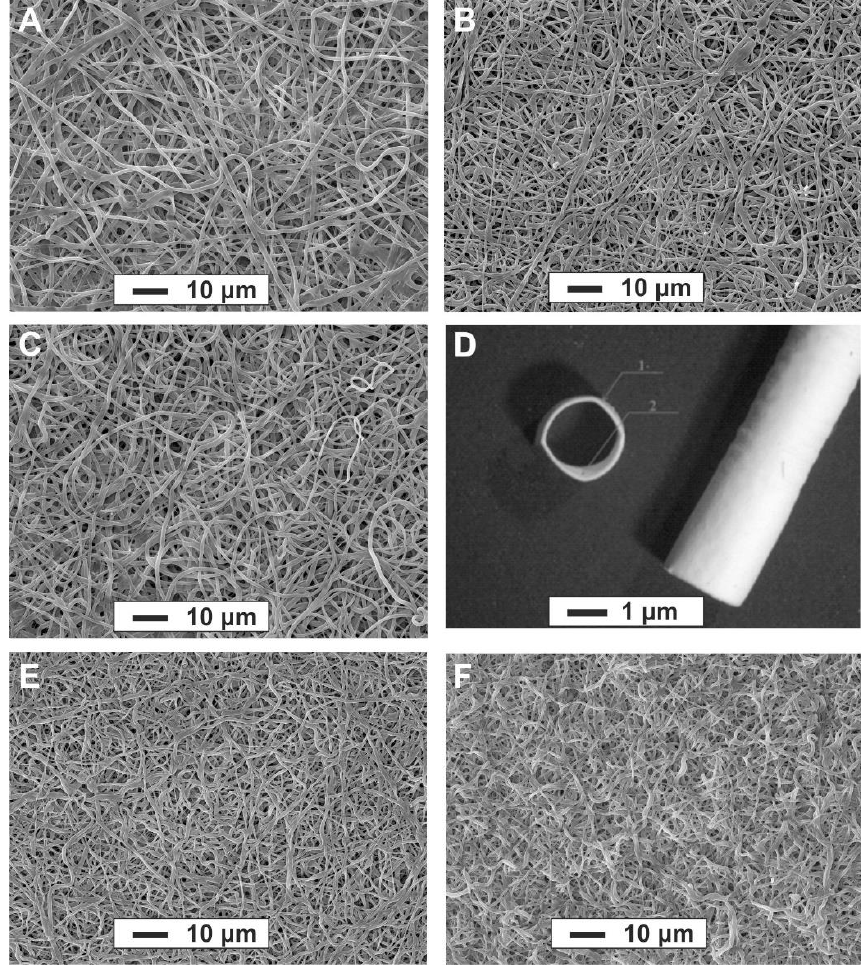
Figure 1. SEM images of electrospun matrices of the following solutions in HFIP: 3.5% Pel-80A scaffold ( A ); 3.5% Pel-80A + 5% Gel scaffold ( B ); 3.5% Pel-80A + 10% Gel scaffold ( C ); Image of electrospun graft containing 3.5% Pel-80A + 10% Gel + 1.5% Bv; scale bar, 1 mm ( D ); 3.5% Pel-80A + 5% Gel scaffold after incubation in PBS for 15 days ( E ) and 30 days ( F ); scale bar, 10 μm; magnifi-